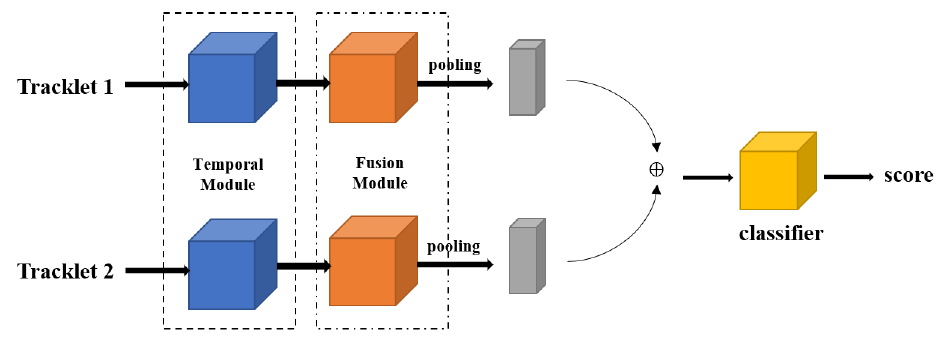
Figure 2. The network model of AFLink.